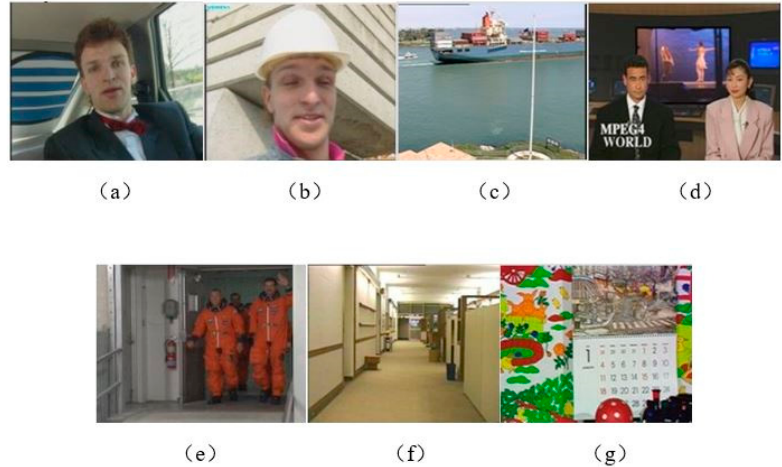
Figure 6. Video frame after data hiding: ( a ) Carphone, ( b ) Foreman, ( c ) Container, ( d ) News, ( e ) Crew, ( f ) Hall, and ( g ) Mobile.